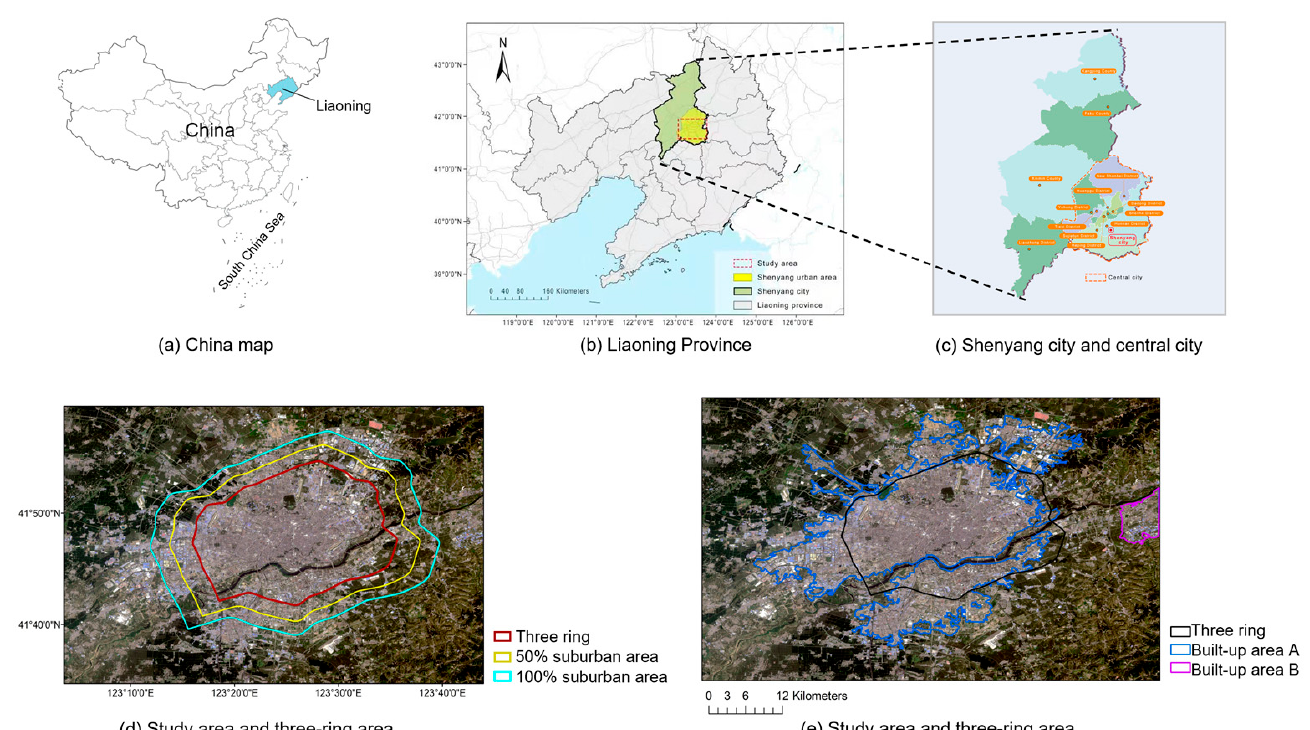
Figure 1. Location of study area and its composition according to China’s land use status remote sensing monitoring database (http://www.resdc.cn, accessed on 19 October 2021).